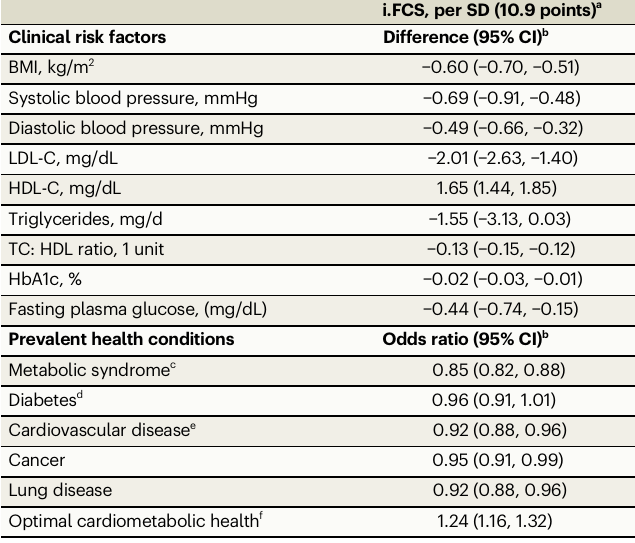
BMI bodymassindex, CI con fi dence interval, CVD cardiovascular disease, HbA1c hemoglobin A1c, HDL-C high-densitylipoproteincholesterol, i.FCS